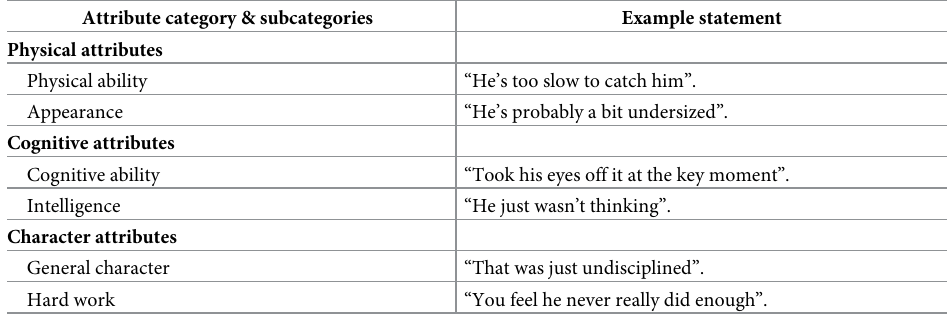
Table 1. Negative statement examples for each main attribute category and